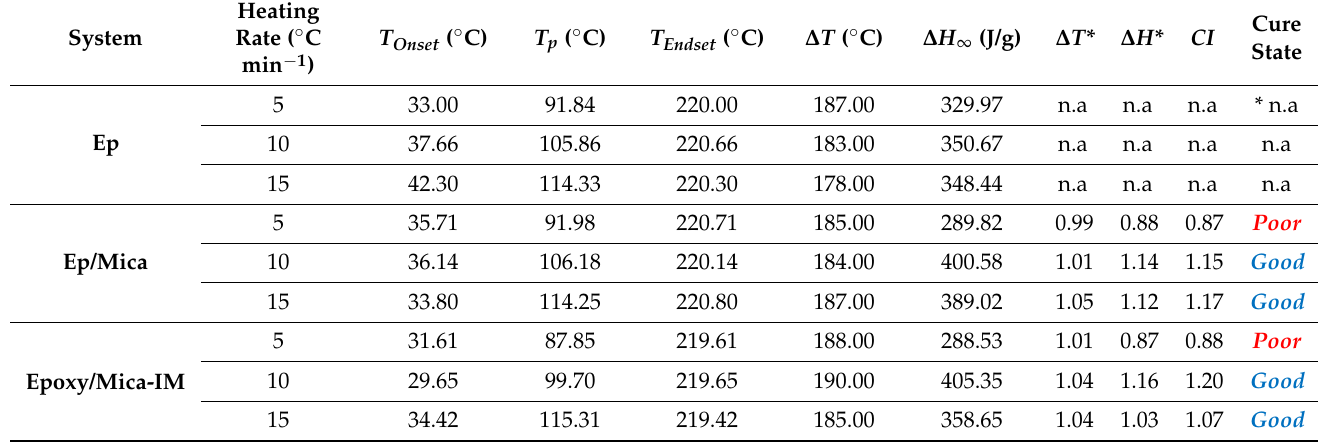
Table 1. Cure parameters assigned to the blank epoxy and its nanocomposites in terms of heating rate. T Onset and T Endset are representative of the onset and endset cure temperatures, and T p features the peak temperature in the DSC thermograms. In addition, ∆ H ∞ is the total heat of cure reaction. Red, blue and green colors are representative Poor , Good and Excellent cure states,